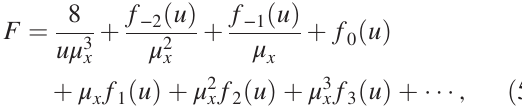
FIG. 8. Quadrupoles ’ strengths of mTME cell as a function of horizontal tune.